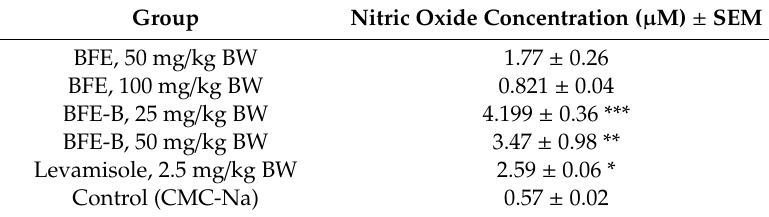
Table 2. E ff ect of water-soluble fibers of P. erosus (BFE and BFE-B) on nitric oxide production in the peritoneal macrophages of mice induced by hepatitis B vaccine.